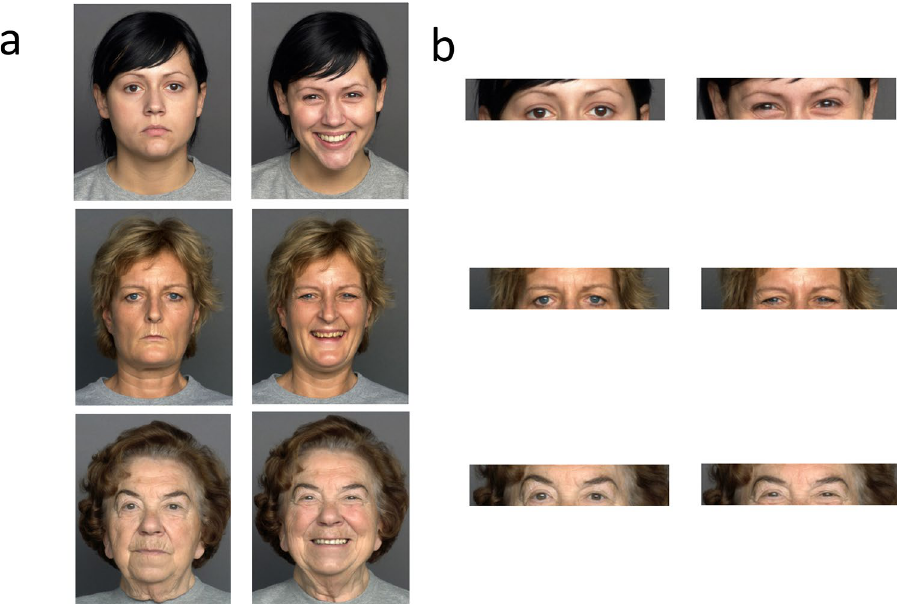
Figure 1. Sample stimuli used in Experiment 1a and Experiment 1b. ( a ) Full neutral and smiling faces of young adults, middle-aged adults, and old adults presented in Experiment 1a. ( b ) Cropped photos of the eye region of the same faces presented in Experiment 1b. Adapted from Ebner, N. C., Riediger, M., & Lindenberger, U. (2010). FACES—A database of facial expressions in young, middle-aged, and older women and men: Development